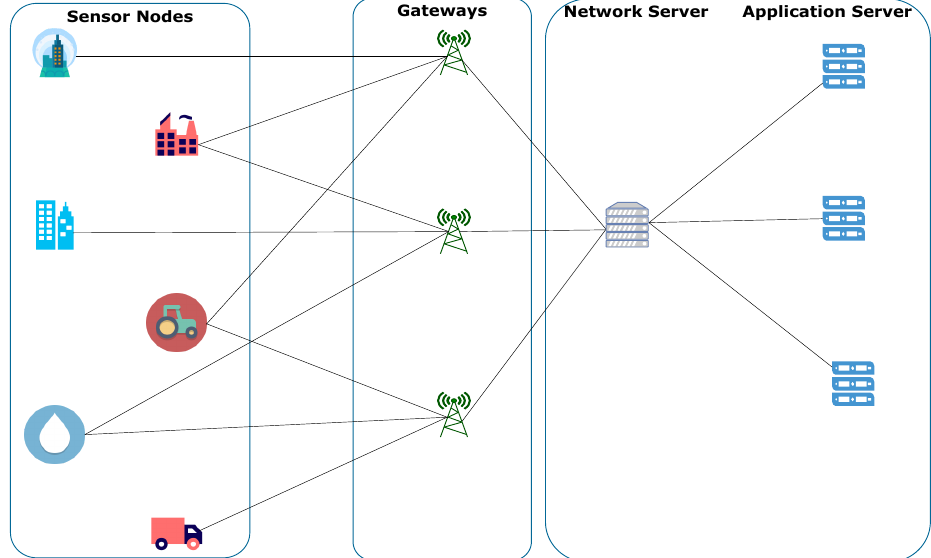
Figure 5. A typical LoRaWAN network